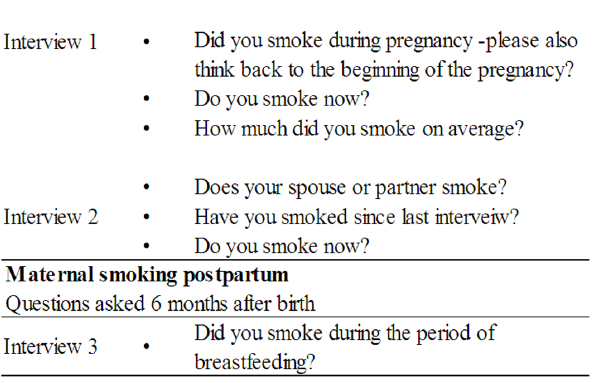
Figure 2. The figure show questions assessing information on maternal and paternal smoking exposure from Interview 1 (obtained around gestational week 16), Interview 2 (obtained around gestational week 32), and Interview 3 (obtained 6 months after child birth).